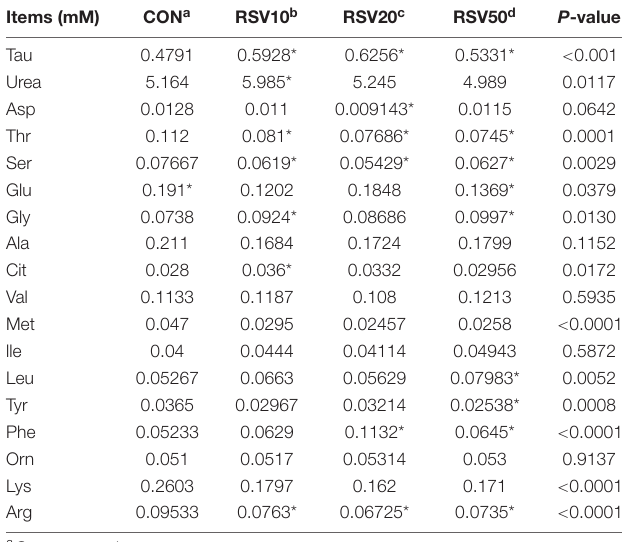
TABLE 2 | Effect of resveratrol on the serum amino acid profiles in weaned